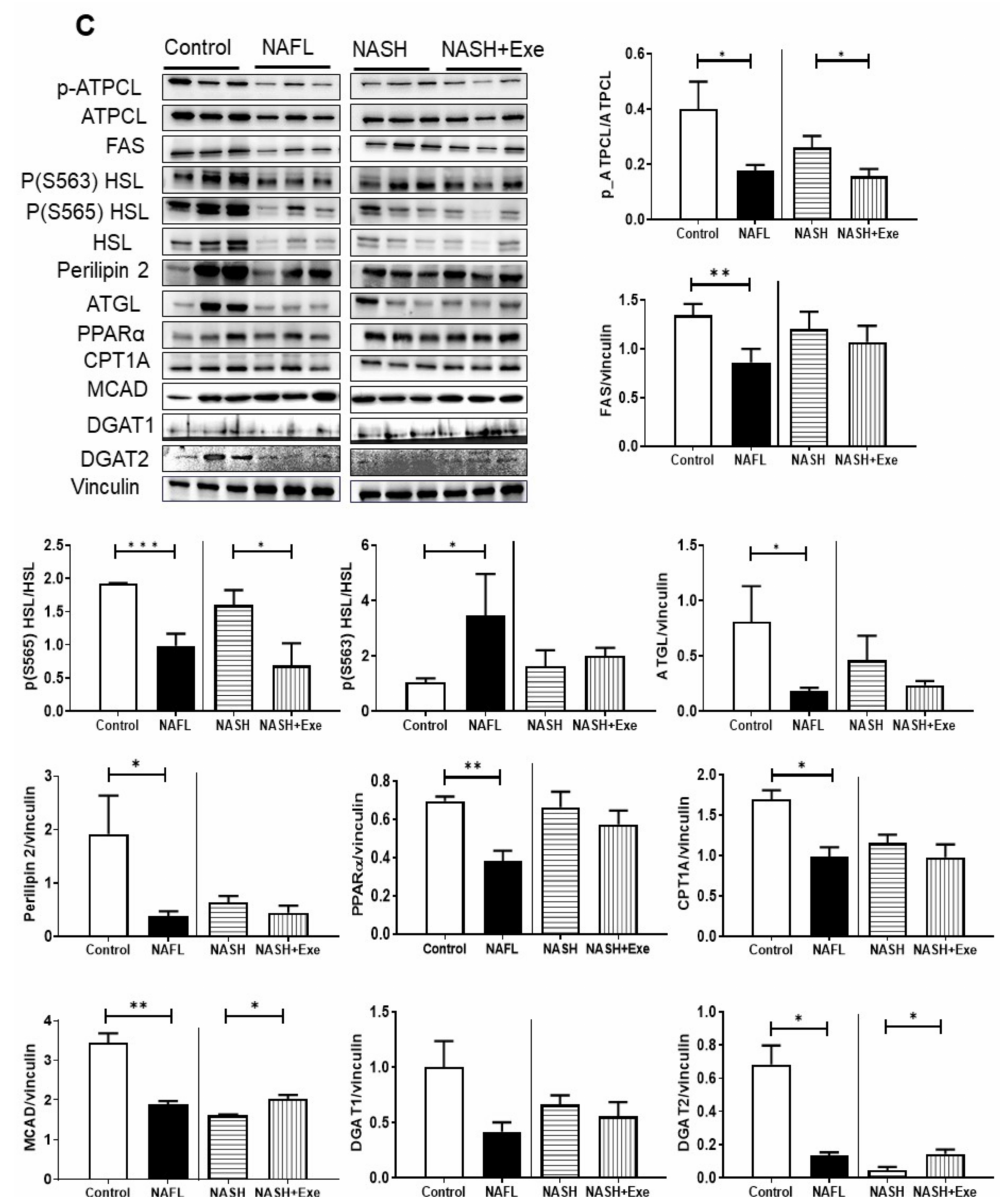
Figure 5. E ff ect of exercise on hepatic lipid metabolism. ( A ) Liver content of triglycerides and free fatty acids (FFA) were compared in mice fed a control diet or a choline-deficient high-fat diet (CD-HFD) for 12 weeks (NAFL) and in mice fed a CD-HFD for 20 weeks with (NASH + EXE) or without exercise (NASH) ( unpaired t -test; ** p < 0.005; *** p < 0.001; **** p < 0.0001). ( B ) Semi-quantitative PCR measurement of CD36 mRNA and fatty acid transport protein 2 (FATP2) and fatty acid transport protein 5 (FATP5) levels in liver extracts relative to β 2-microglobulin. CD36 was higher in NAFL than in controls ( p < 0.001). FATP5 and FATP2 were lower in NAFL than in controls. ( C) Immunoblots of liver homogenates comparing control and NAFL mice, and NASH and NASH + EXE groups. The signals from immunoblots were quantified and normalized with vinculin and are reported as mean ± SD ( n = 3 per group). (ATGL, adipose triglyceride lipase ; ATPCL, ATP citrate lyase; FAS, fatty acid synthase; HSL, hormone-sensitive lipase; CPT1A, carnitine palmitoyltransferase alpha; MCAD, medium-chain acyl-CoA dehydrogenase (unpaired t -test; * p < 0.05; ** p < 0.005; *** p < 0.001). Details of Western blots are given in Figure